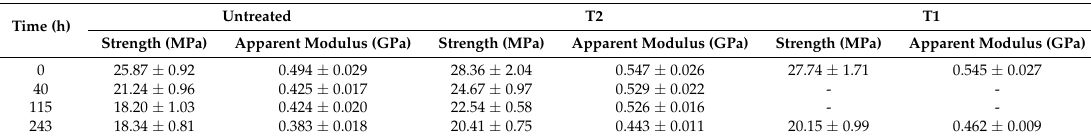
Table 6. Tensile properties perpendicular to fiber direction of FA treated and untreated composites after water absorption (average and standard